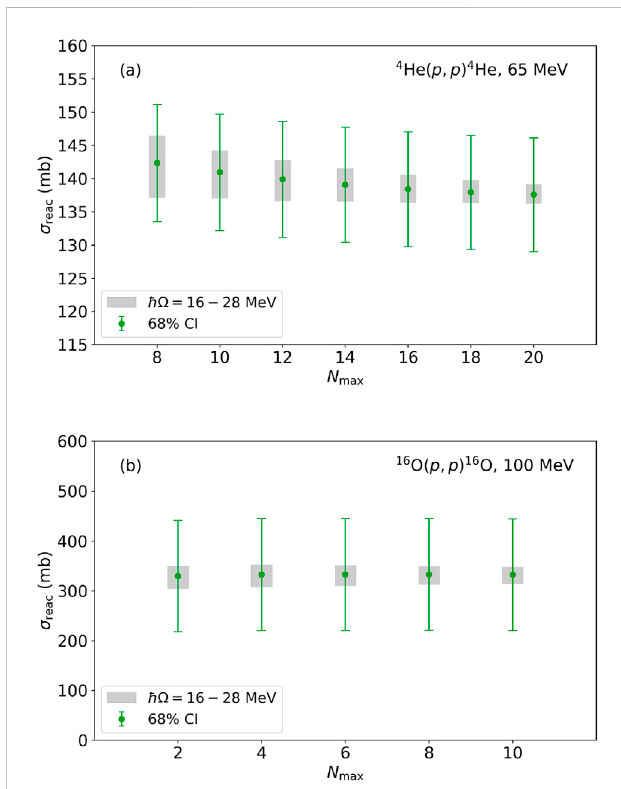
FIGURE 3 Reaction cross section for proton scattering on (A) 4 He at 65 MeV and (B) 16 O at 100 MeV, both at N2LO as a function of N max . The error bars show a 68% credible interval (CI) from using a pointwise error estimationwiththeLO,NLO,andN2LOresults.Theshadedregions show variations with respect to the harmonic oscillator parameter Z Ω . The values of the expansion parameters used were Q = .47 for 4 He at 65 MeV and Q = .69 for 16 O at 100 MeV. Note the different scales in (A, B)